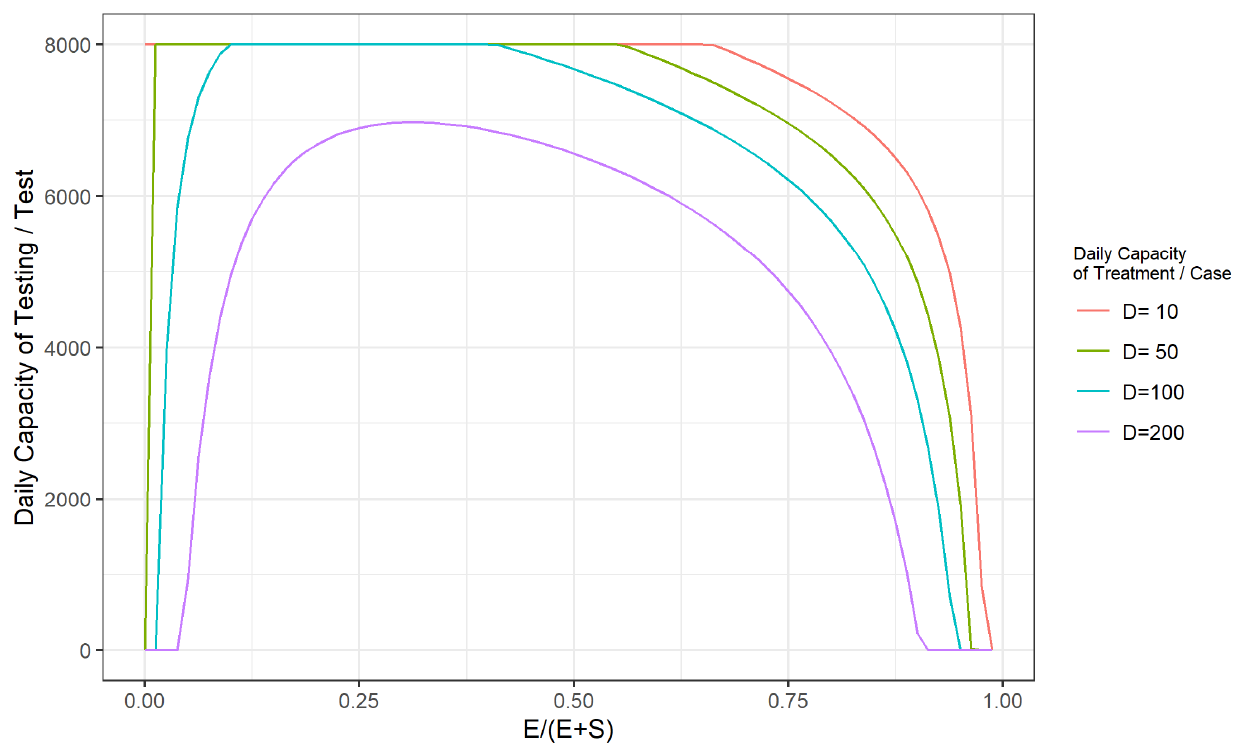
Figure A8. The effect of daily testing capacity on the ability to control the potential development level of the epidemic ( S + E = 9000, I = 1000).